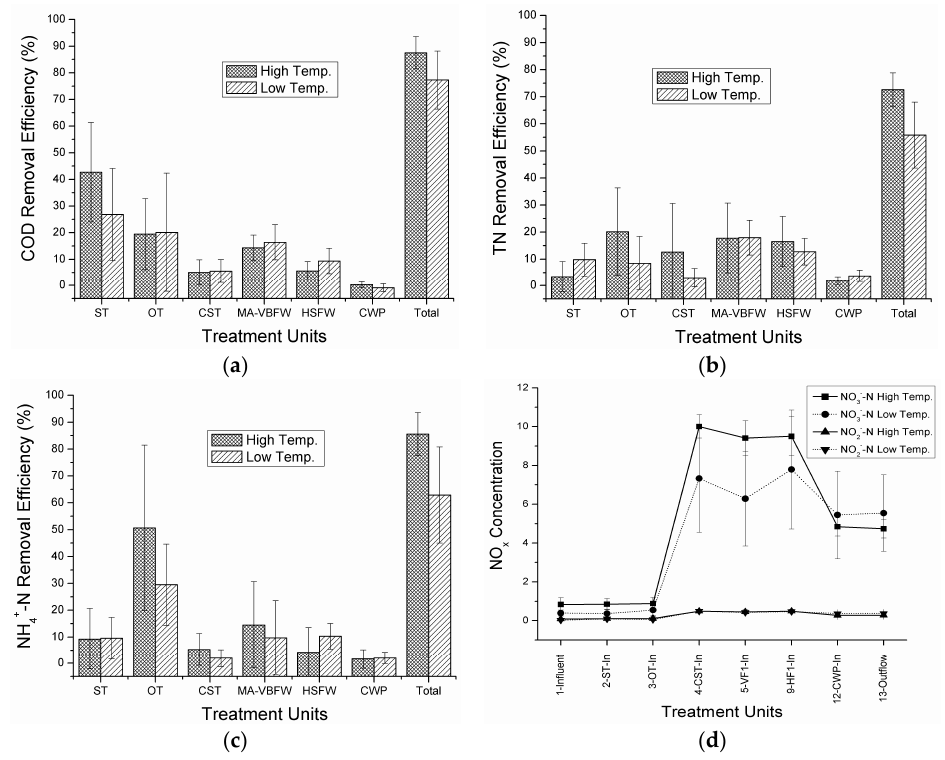
Figure 3. Stepwise removal efficiency of organics and nitrogen. ( a ) Chemical oxygen demand (COD) removal efficiency in all treatment units during summer and winter; ( b ) Total nitrogen (TN) removal efficiency at different treatment stages during summer and winter; ( c ) Ammonium nitrogen (NH 4+ ‐ N) removal efficiency at different treatment stages during summer and winter; ( d ) Distribution of NOx (NO 3 − ‐ N and NO 2 − ‐ N) concentrations along with the treatment flow routes during summer and winter.